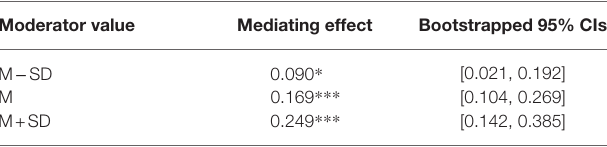
TABLE 6 | Mediating effect of online learning engagement conditional on teacher emotional support. Moderator